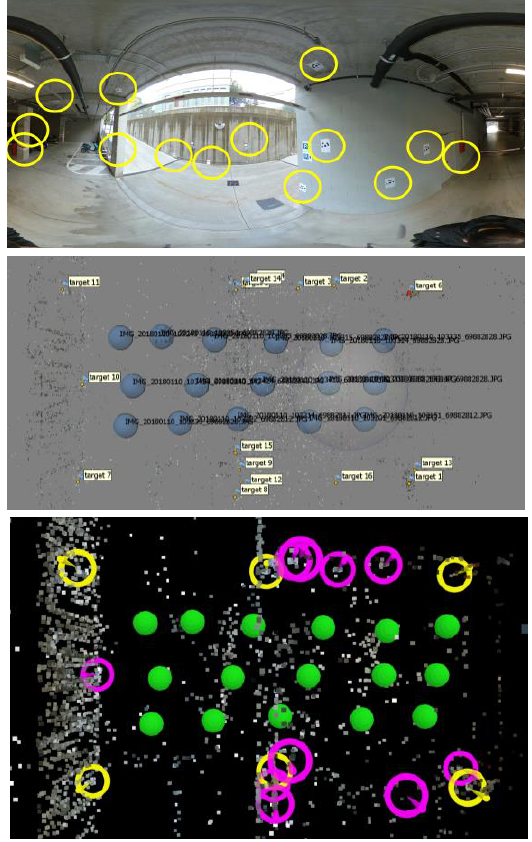
Figure 2. A spherical image of the test with the targets (top) and a vertical view of the test field after data processing with PhotoScan (middle) and Pix4D (bottom) Green: camera station, Yellow: GCPs, Purple: Check Points Statistics check points are illustrated in Table 2 and show an accuracy of about 6 mm, whereas the test site is 10.9 m x 6 m x